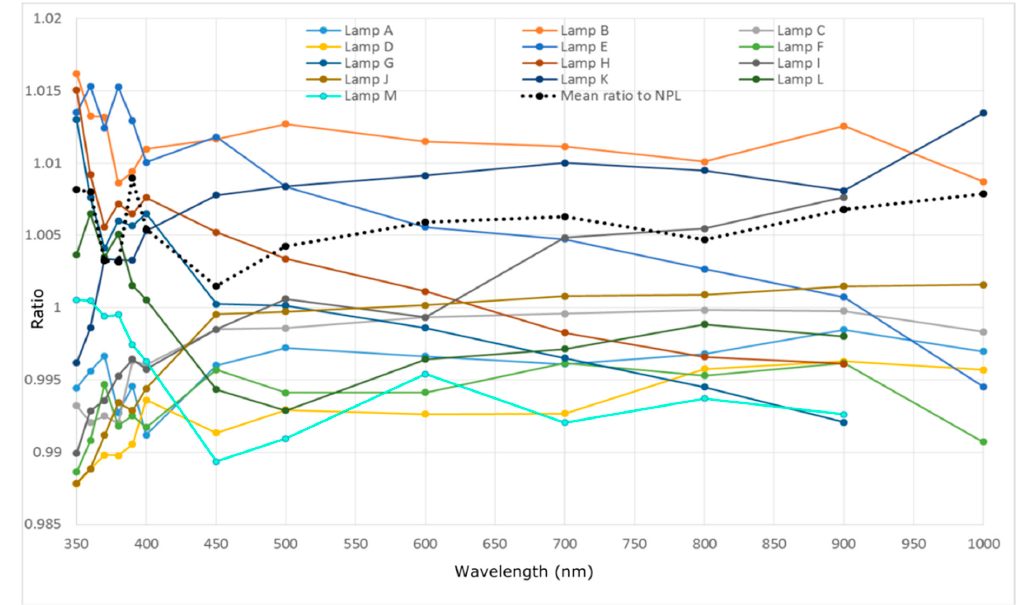
Figure 5. Comparison between irradiance sources from several OCR calibration laboratories, including the NPL spectral irradiance scale as a reference. Reproduced with permission from [43].